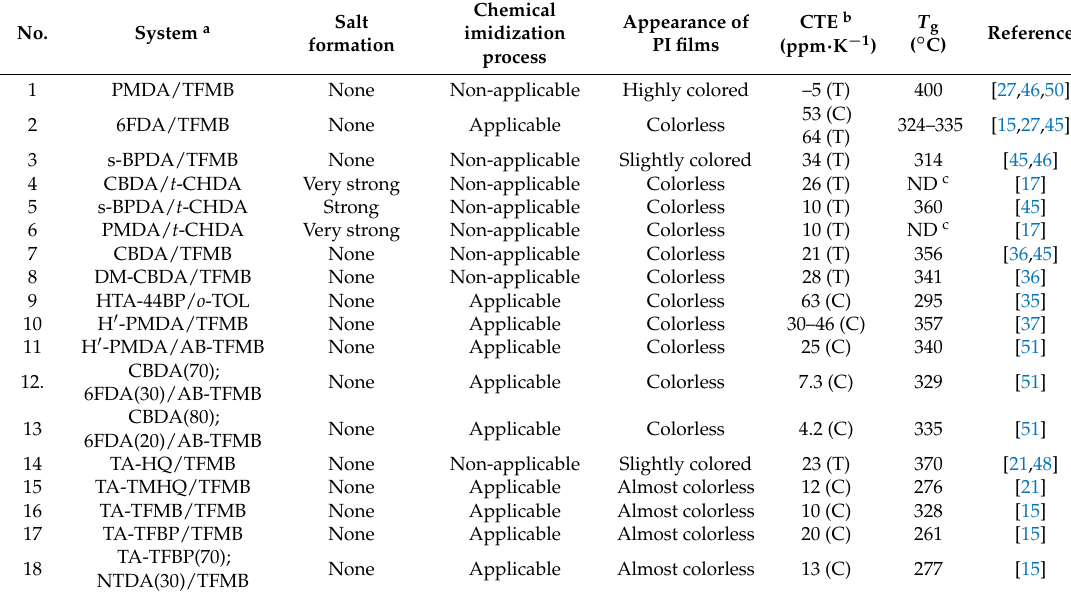
Table 1. Salt formation behavior in the PAA polymerization and selected properties of PI films for the systems that we have investigated so